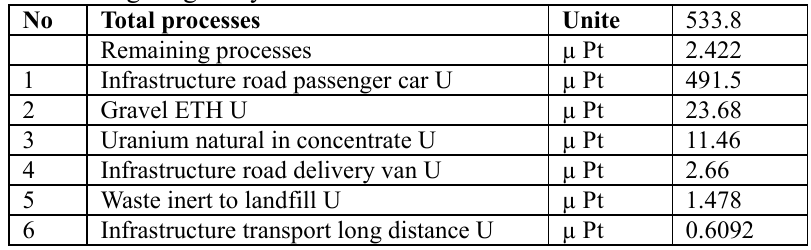
Table 3 Land use sub processes weighting analysis.